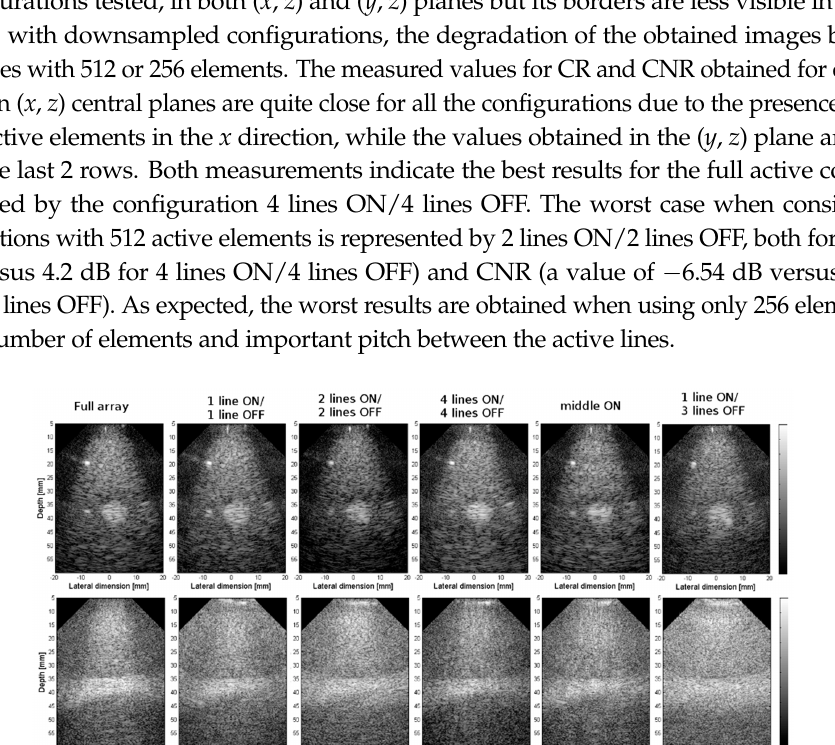
Figure 8. Examples of Power Doppler illustrations of two US acquisitions on a blood vessel mimicking phantom. The US probe is parallel ( θ = 0) to the phantom-tube for the first example (first row) while the probe was tilted at an angle of 12° from the phantom-tube. Axial ( a ), lateral ( b ) and 3-D view rendering ( c ) is illustrated here. A dynamic of 50 dB has been used for the B-mode grayscale image. 4. Discussion This study illustrates the development and feasibility of a real-time 4-D US imaging platform in full array mode by synchronizing emission and reception of up to 1024 elements independently. The initial experiments conducted in this study demonstrate the flexibility of the modular US platform, having the possibility to reconfigure it according to the number of available Vantage systems